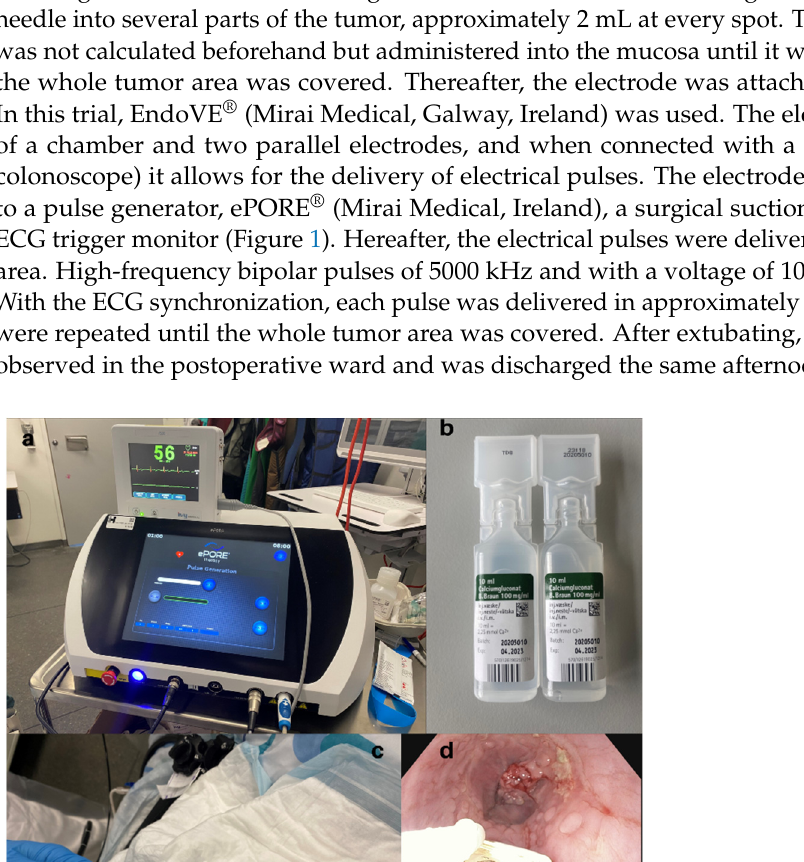
Table 1. Baseline characteristics. Baseline characteristics from all ten patients, including de- mographics, tumor characteristics, previous oncological treatment, initial dysphagia score, and treatment data.